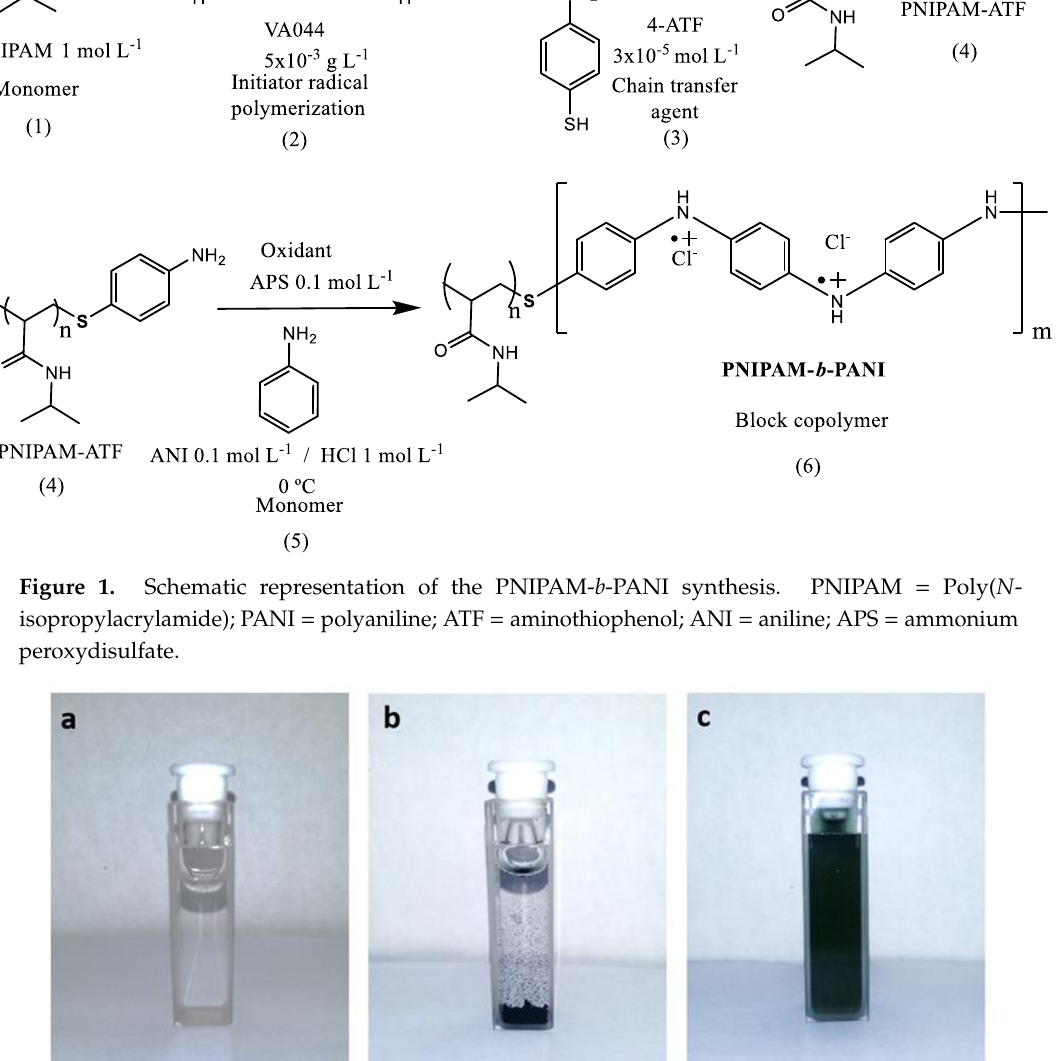
Figure 2. Photographs of optical cells containing aqueous solutions of: ( a ) PNIPAM, ( b ) PANI, and ( c ) PNIPAM- b -PANI at 20 °C.